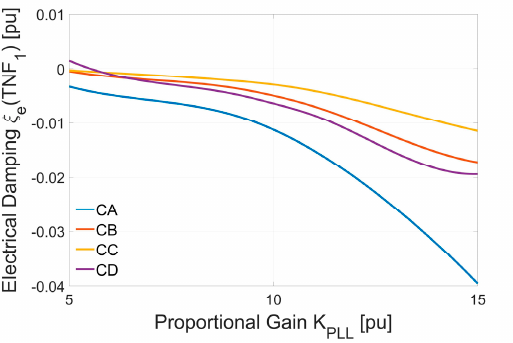
19 of 25 Figure 21. Electrical damping ξ e (TNF 1 ) related to K PLL variations.